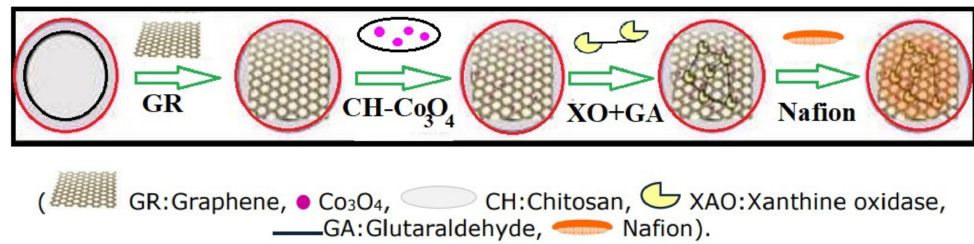
Figure 6. Fabrication process of the modified electrode. Reprinted (adapted) with permission from Ref. [65]. Copyright 2017, Turkish Chemical